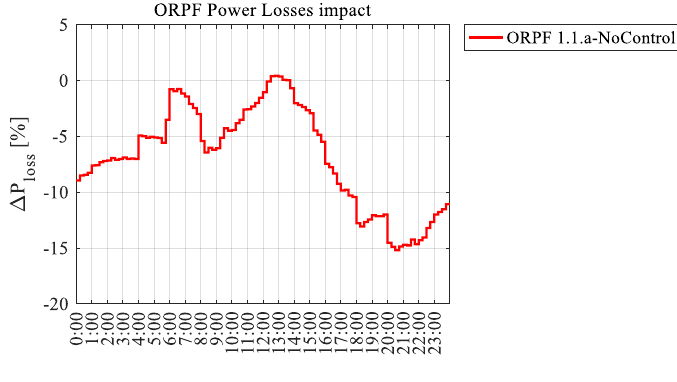
Figure 19. ORPF 1.1.a relative power losses.